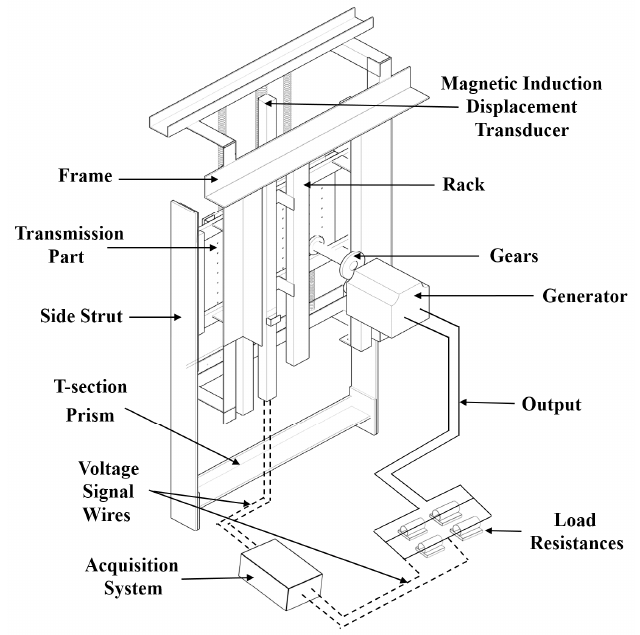
Figure 4. Energy conversion system.